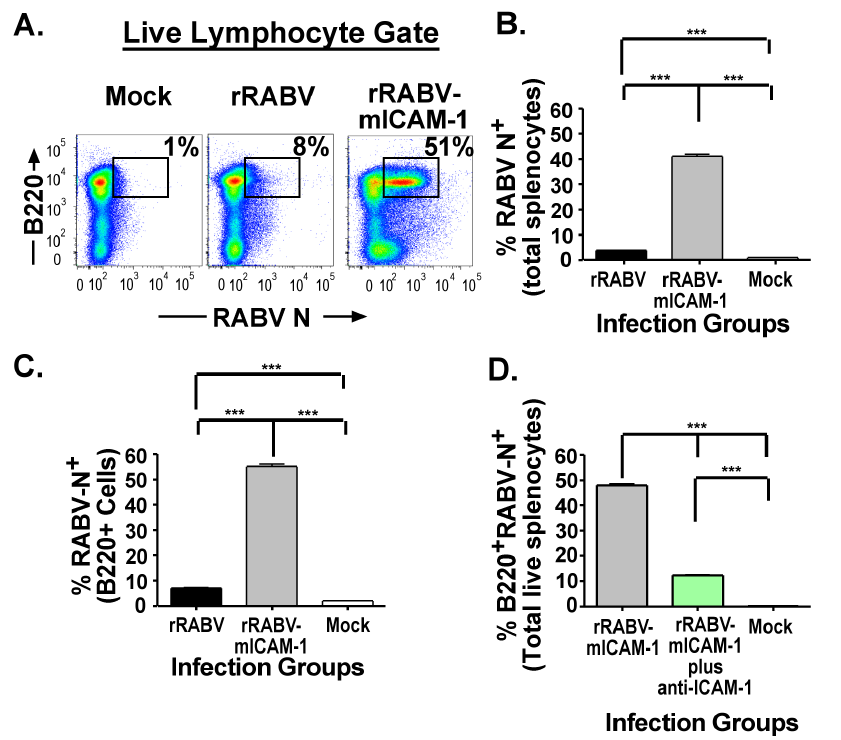
Figure 2. rRABV-mICAM-1 infects primary murine splenocytes and B cells more efficiently than the parental virus, rRABV. Naı¨ve primary murine splenocytes were infected at an MOI of 5 with rRABV or rRABV-mICAM-1, or treated with media alone (mock-infected) for two days in- vitro . No additional mitogens were added to the culture to maintain the B cells and accessory splenocytes in a resting state similar to that in which they would exist in-vivo at the time of initial immunization. A) Representative gating strategy of total live splenocytes stained for intracellular RABV N as a marker for infection and for cell-surface expression of B220 as a maker for B cells. The percentage in the upper right quadrant is a representative example of the percentage of B220 + B cells infected with the rRABV-based vaccine. B) Percent RABV N + cells in the total live lymphocyte gate. C) Percent RABV N + cells in the B220 + cell population. D) Pretreatment of sucrose-purified rRABV-mICAM-1 with a neutralizing anti-ICAM-1 antibody significantly reduced infection of B cells in culture. To compare two groups of data, we used an unpaired, two-tailed Student’s t test. (* p , 0.05; **, p , 0.01; ***, p , 0.001) titers measured by ELISA in Figure 5, VNA titers were similar in mice immunized with 10 5 ffu/mouse with either rRABV or